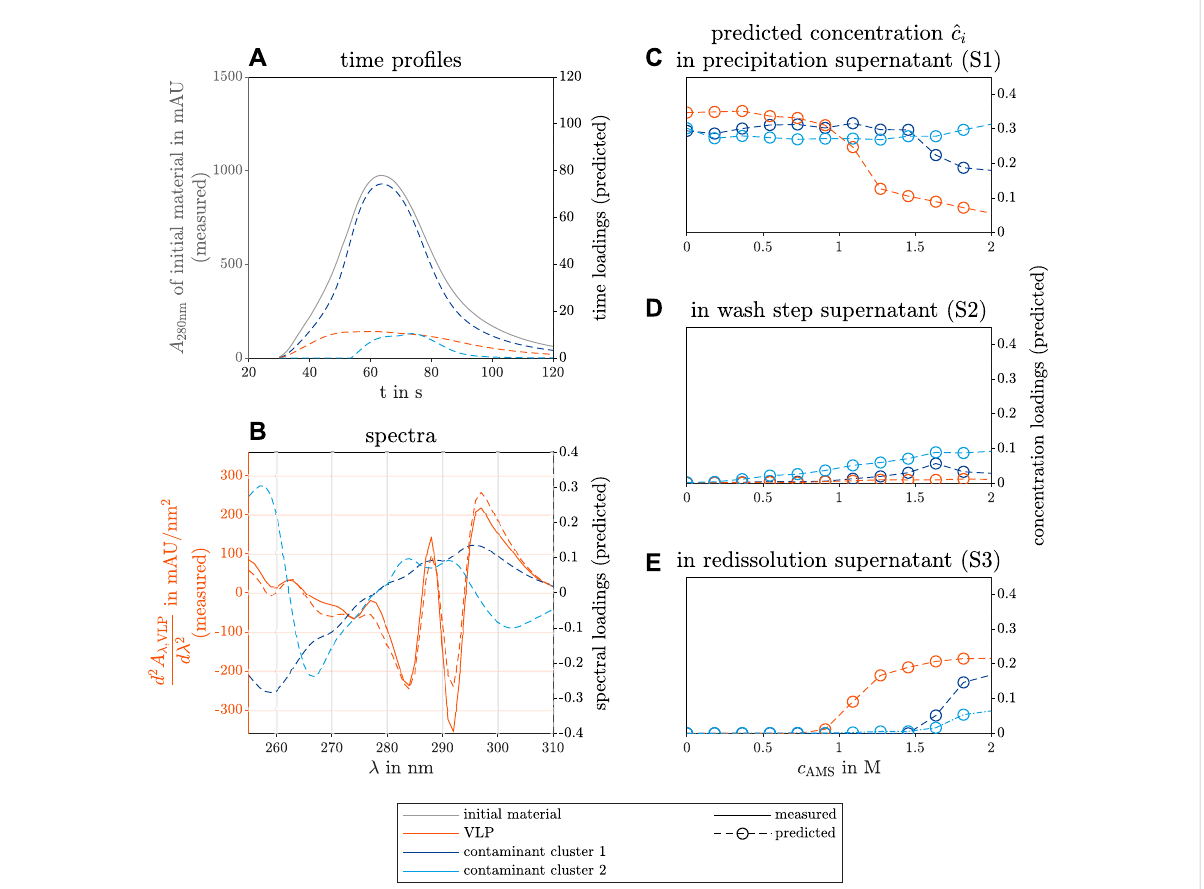
FIGURE 6 PARAFACmodelresultsoftheselectiveVLPprecipitationscreeningfrom E.coli lysate.Themeasuredreferencedata(leftaxis)andthepredicted loadings (right axis) are illustrated with solid and dashed lines, respectively. The colors gray, orange, dark blue, and light blue indicate the initial raw material, the VLPs, and two contaminant clusters. The time course loadings in (A) show the PARAFAC model predictions of the species absorption loadings over time t in the fl ow cell of the UV/Vis detector. Additionally, the spectral absorption of the initial solution A 280nm is shown at wavelength 280 nm over time. The spectral loadings in (B) illustrate the predicted contaminant spectra over the wavelength λ and the similarity between the predicted loadings and the measured second derivative of the VLP spectrum d 2 A λ , VLP . The predicted concentration loadings ^ c i are shown d λ 2 over varying precipitant concentration c AMS during the precipitation in (C) , wash step (D) , and redissolution process step (E)